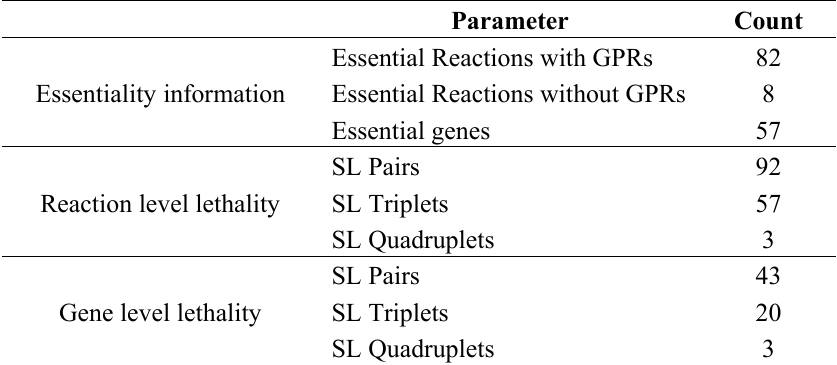
Table 5. Chinese Hamster Ovary (CHO) 1.2 model statistics on ES and